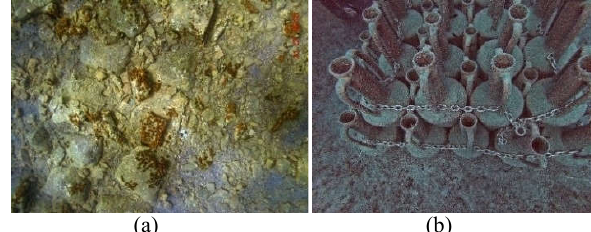
Figure 2. corrected (a) imagery with CLAHE based algorithm